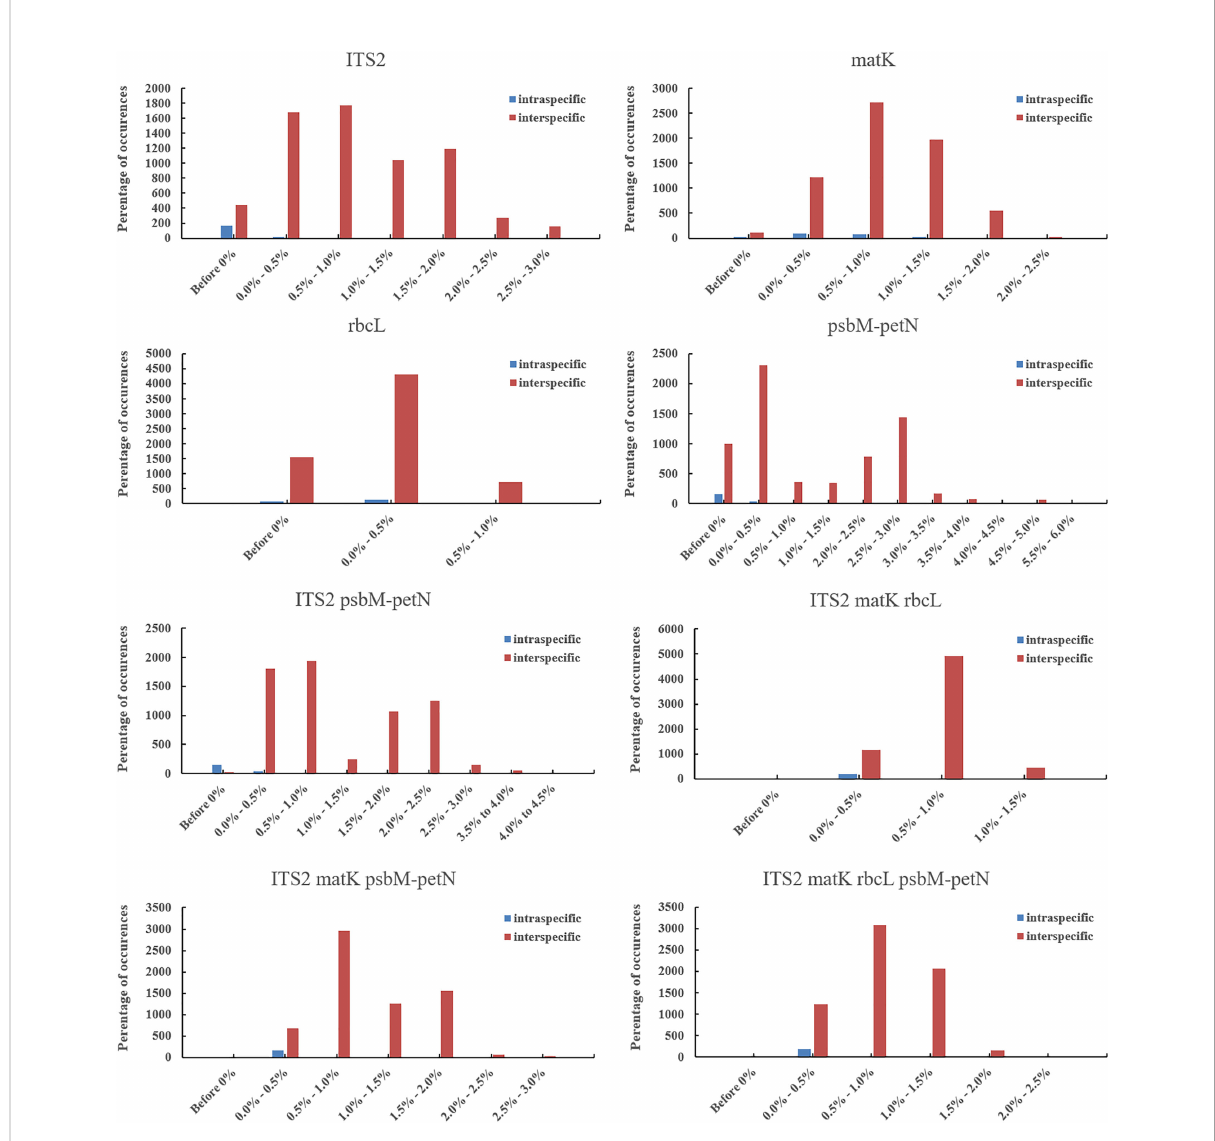
FIGURE 2 Interspecies and intraspeci fi c distance distributions of candidate DNA barcodes. Blue represents the distance between intraspeci fi c accessions, and red represents distance between pairwise different species